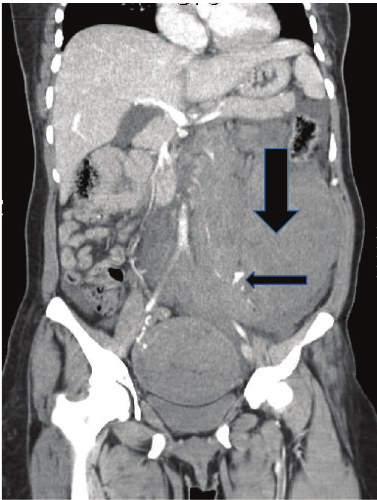
Figure 2: Retroperitoneal hematoma: coronal image of CT of the abdomen shows aneurysm in the left lower quadrant (narrow arrow), associated with a large left lower quadrant hematoma (bold arrow).